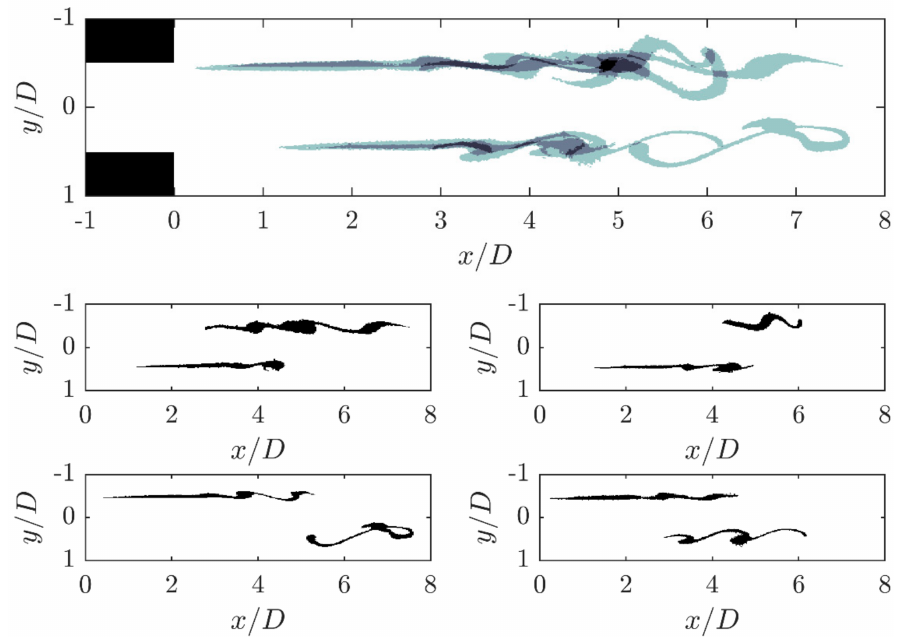
Figure 14. Compilation of droplet images where the droplets are influenced by Kelvin-Helmholtz instabilities. Top : Overlay of the images; Bottom : Individual images of the droplet filaments.